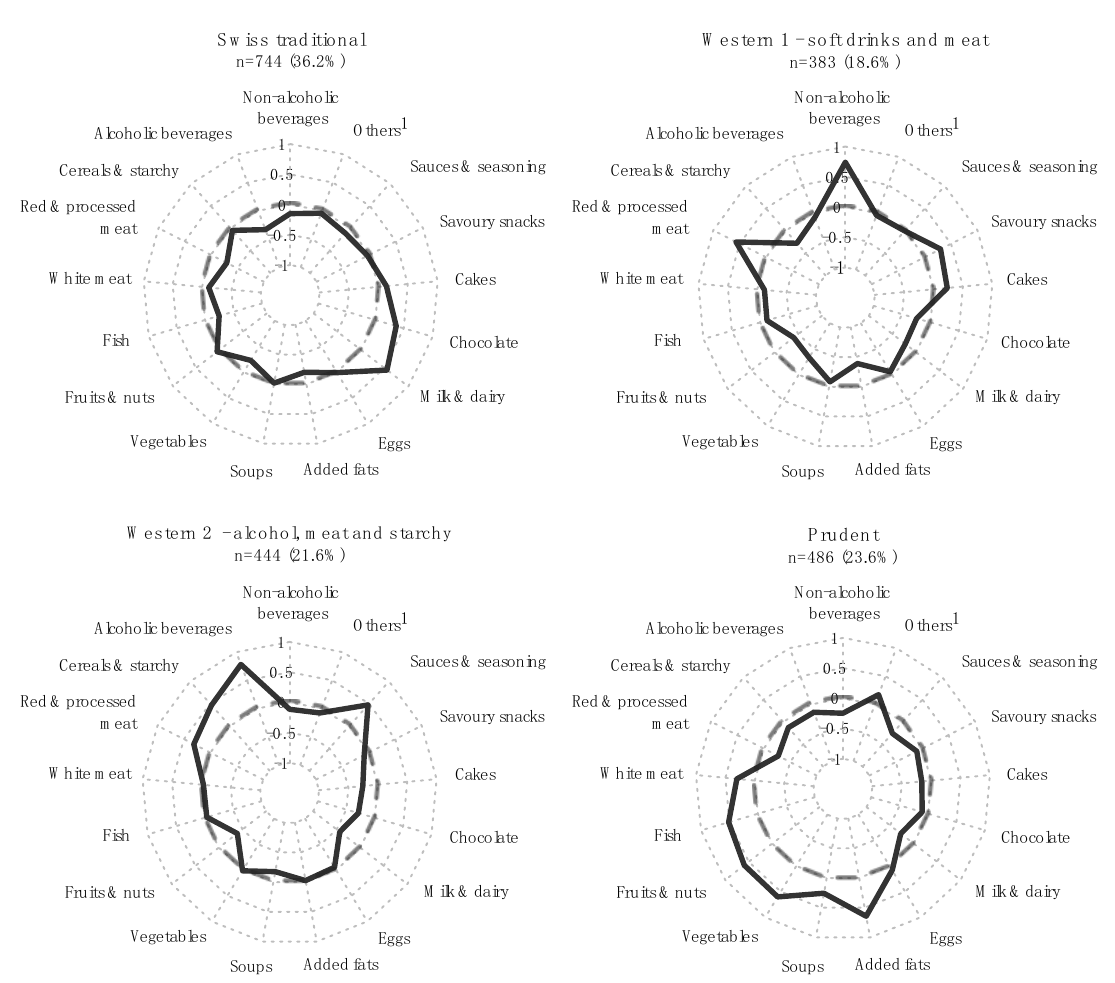
Figure 1: Food consumption profiles in the four dietary patterns relative to the overall population. Energy-standardised consumptions of the 17 food categories were centred and reduced for the overall study population (z-standardisation). Each axis of the radar plots indicates the mean of the centred-reduced energy-standardised consumptions of one food category within one dietary pattern, i.e., how the consumption in a dietary pattern deviates from the consumption in the overall population. A positive and a negative value indicate consumptions above and below the mean of the overall population, respectively. 1 Others include meat substitutes, milk substitutes and meal replacements (all categories are described in Table S1, Supplementary Materials).